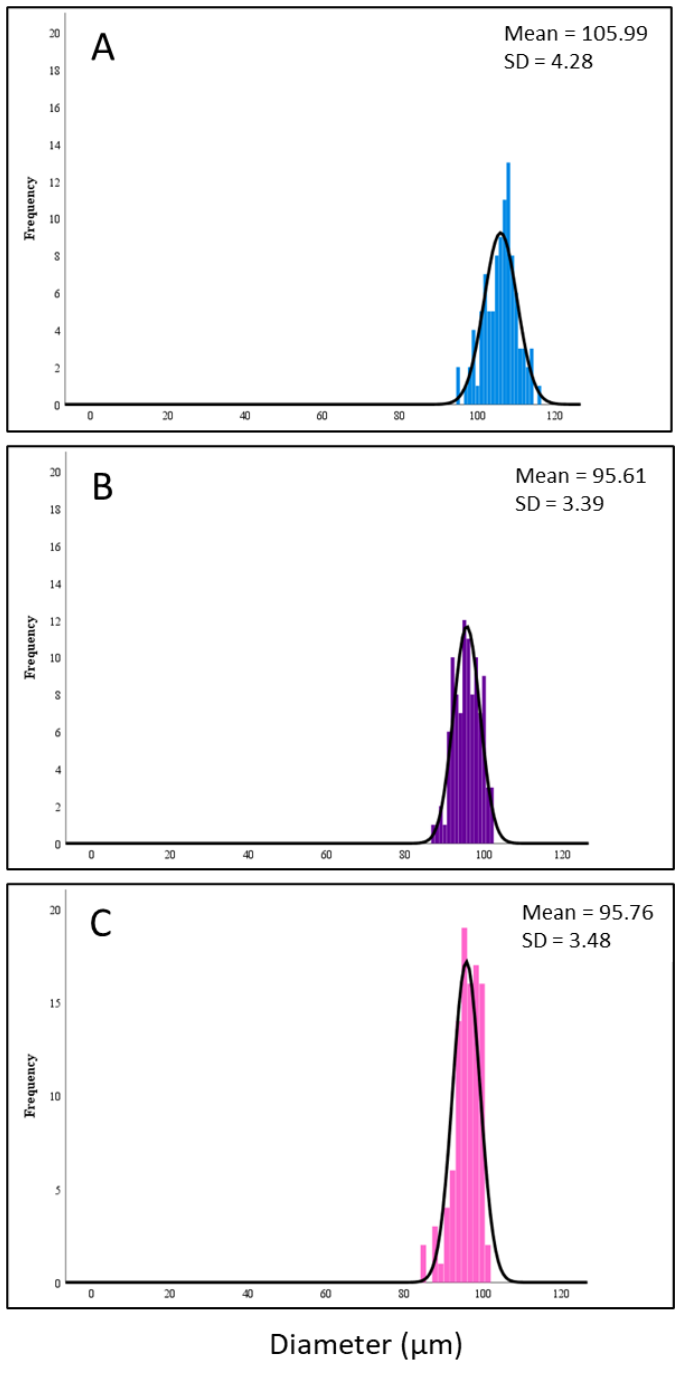
Figure 2. Particle size distribution of microcapsules: P55 ( A ), P73 ( B ) and P91 ( C